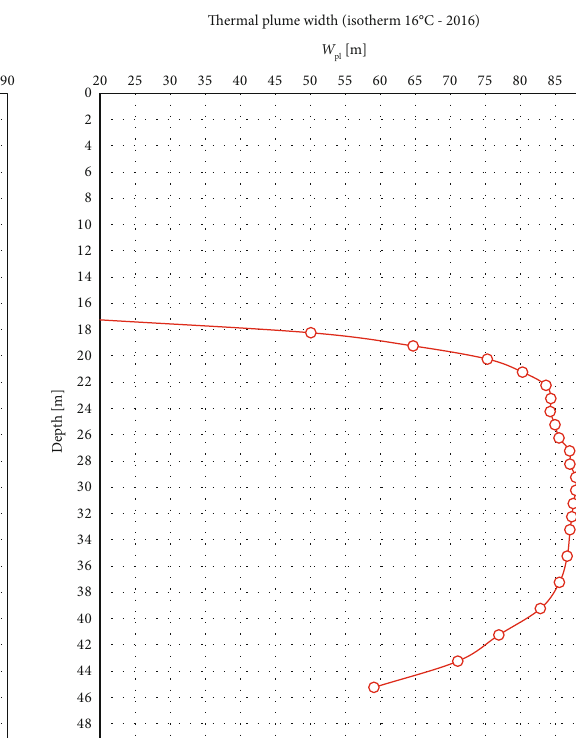
pl ) for each monitored season (2010 and 2016).